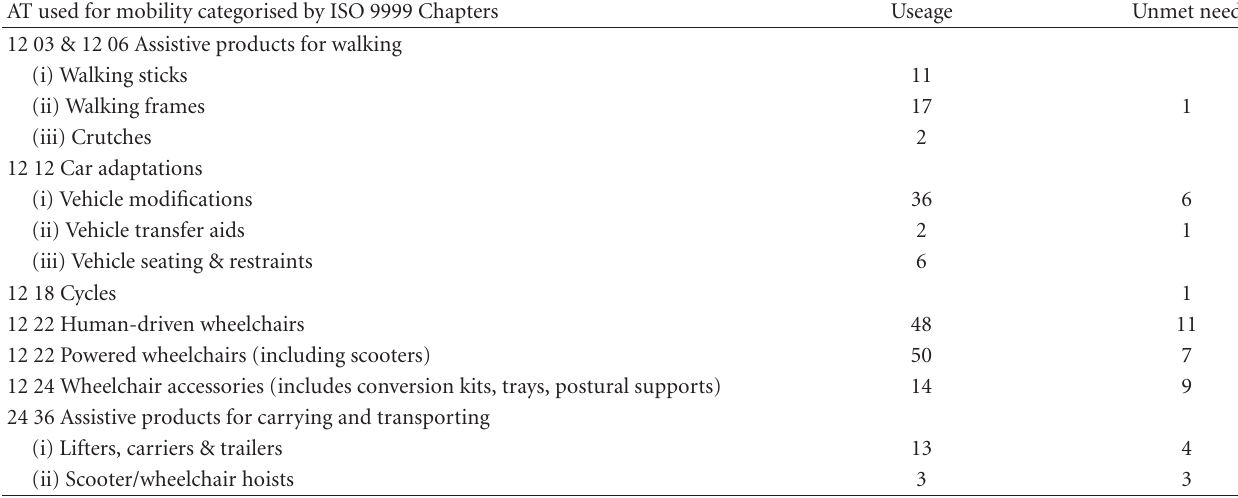
Table 2: Mobility device useage and unmet need